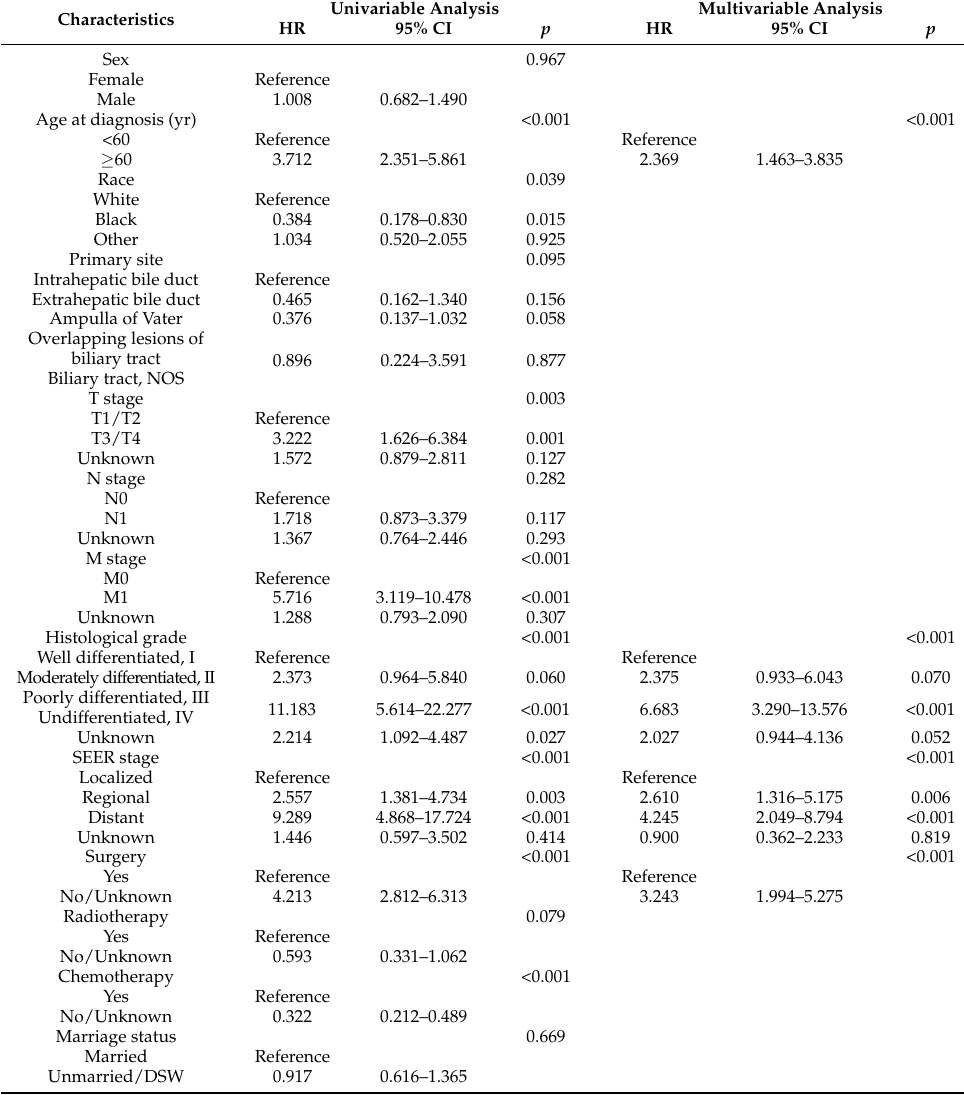
Table 3. Univariable and multivariable Cox proportional hazard model analysis of disease-specific survival in patients with primary bile duct and ampullary neuroendocrine neoplasms.